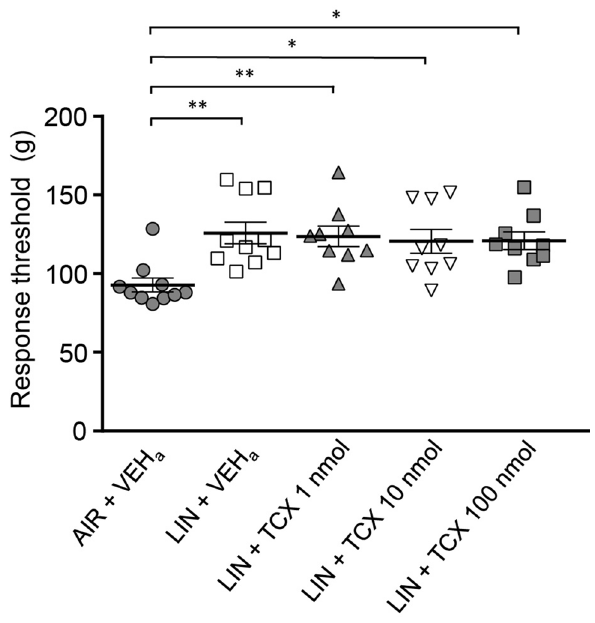
Figure 5. Intrathecal administration of TCX OX2 29 (orexin 2 receptor antagonist) did not suppress linalool odor-induced analgesia in the tail pincher test. n = 10 for AIR + VHE a and LIN + VHE a group. n = 9 for LIN + TCX 1 nmol, LIN + TCX 10 nmol, and LIN + TCX 100 nmol group. AIR; odorless air exposed mice, LIN; linalool odor-exposed mice, VEHa; mice which received intrathecal injection of vehicle for antagonist, TCS; mice which received intrathecal injection of OX2 receptor antagonist. Bars represent mean ± SEM. ** p < 0.01, * p < 0.05 (Tukey’s multiple comparison